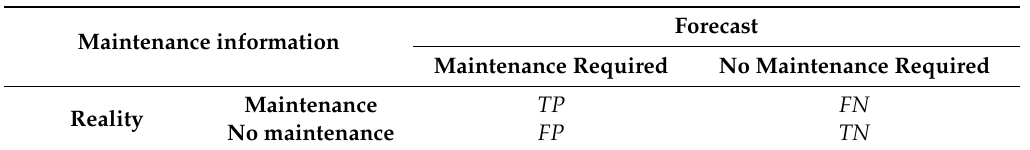
Table 1. Confusion matrix analysis